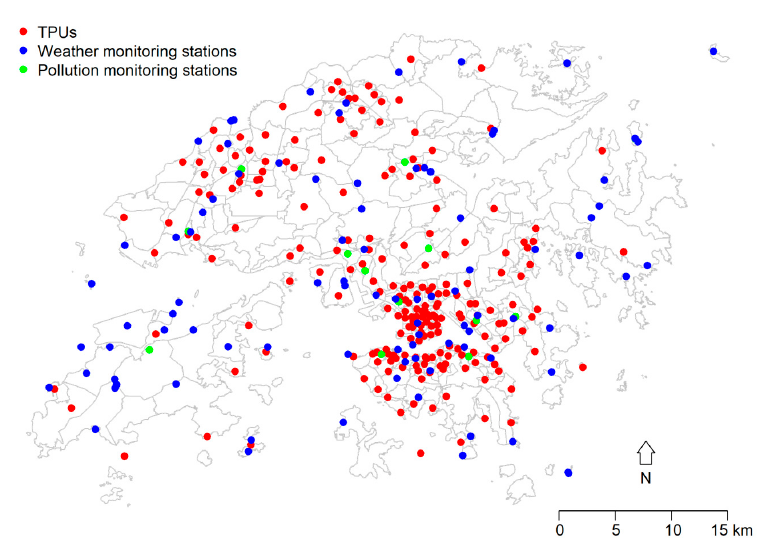
Figure 1. Locations of TPU centroids, weather, and air quality monitoring stations.